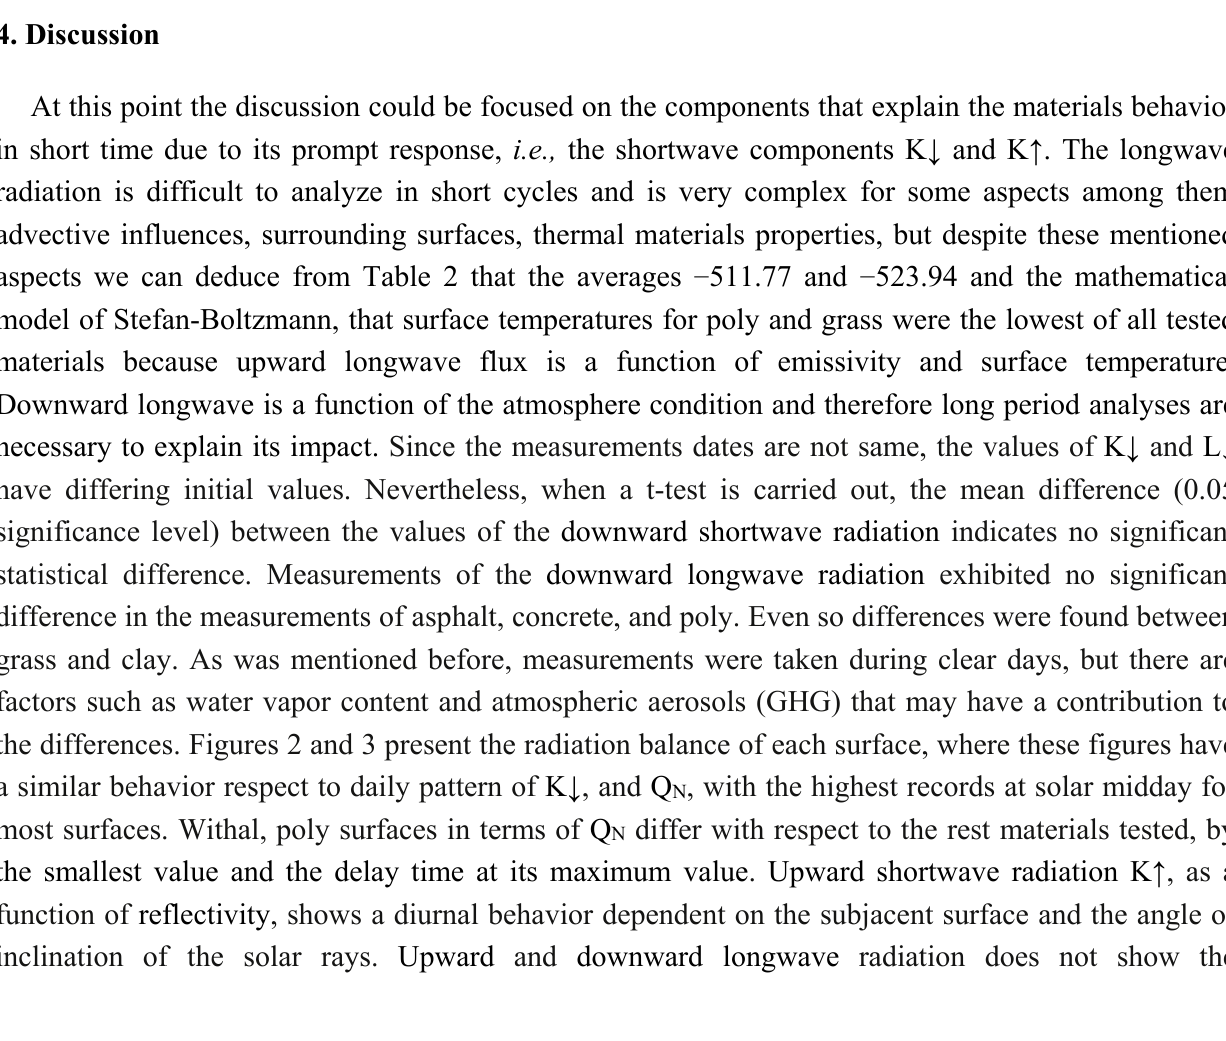
Table 4. Average of NR01 components divided by Q